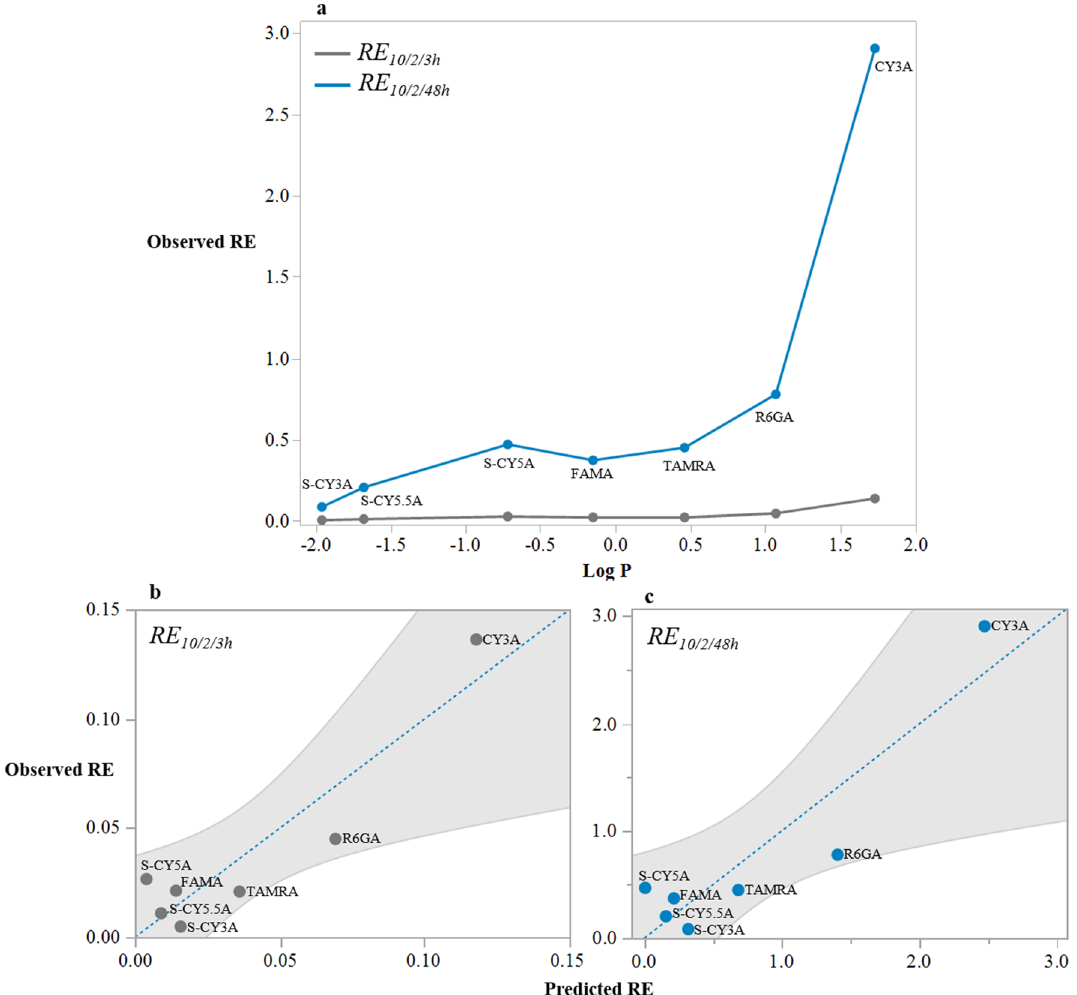
Figure 10. Relationship between observed RE and LogD for the short incubation (0–3 h) and prolonged incubation period (0–48 h) ( a ). ( b ) Plot of the observed RE 10/2 versus the predicted RE 10/2 in case of the short incubation (0–3 h), ( c ) and in case of the prolonged incubation period (0–48 h). Dashed line is the line of fit, shade color is the confidence interval of the model (95%). The image was produced using JMP (version 15.1. SAS Institute Inc., Cary, NC, 2019) and arranged in GIMP (version 2.10.24 https:// www. gimp. org/ 2021)